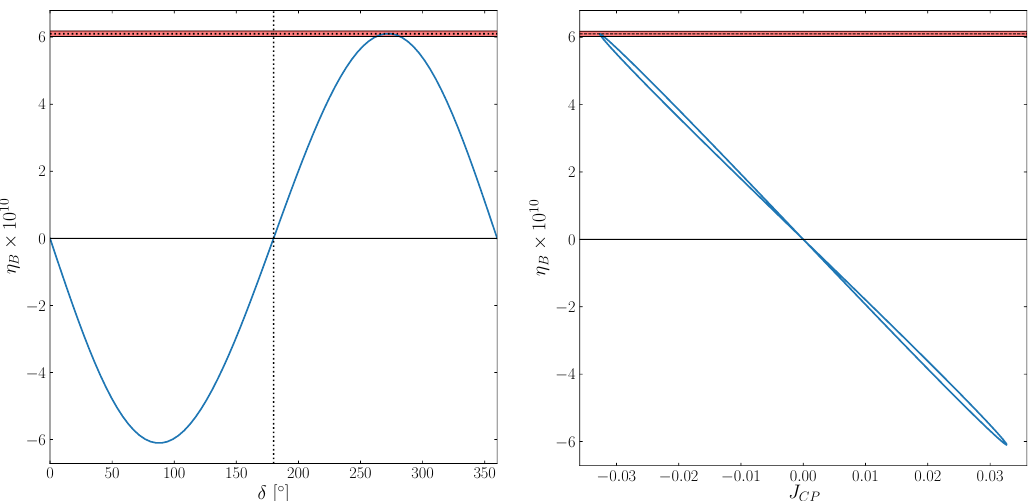
Figure 7 . The baryon asymmetry from leptogenesis with M 1 = 10 11 GeV and N 3 decoupled, where CP violation is provided only by the Dirac phase (cid:14) . The red bands indicate the values in 1 (cid:27) agreement with the observed value (cid:17) B . Left: a plot of (cid:17) B against (cid:14) , showing successful CMB leptogenesis near the maximal CP -violating value (cid:14) = 270 (cid:14) . Right: the corresponding parametric plot of (cid:17) B with J CP as (cid:14) is varied. See the text for further